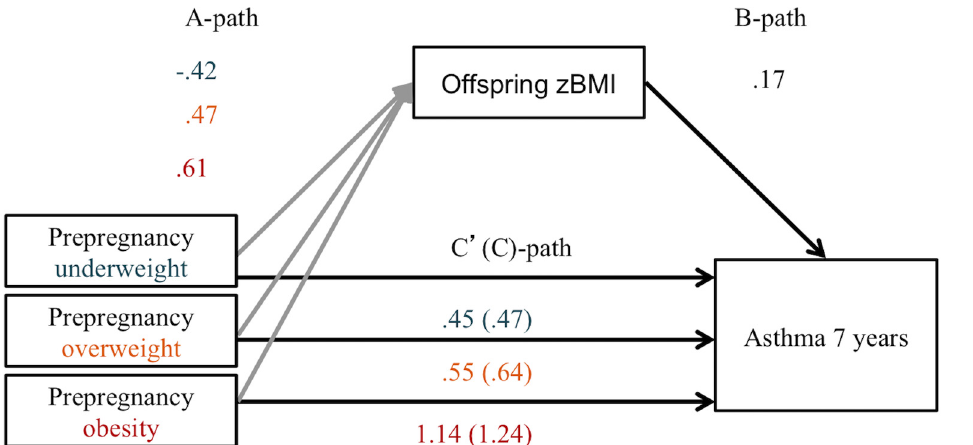
Fig 3. Indirect effect of pre-pregnancy BMI on ever asthma at age 7 – 8 years through offspring BMI z-score at age 5 years (n = 1787). Adjusted for: maternal age, parental asthma, ethnicity, maternal education, A-path: a-coefficient describing the change in offspring ’ s zBMI per BMI category in comparison to normal maternal BMI. B-path: b-coefficient describing change in offspring asthma risk per 1 point change in offspring zBMI when maternal BMI is constant. C ’ (C)-path: direct (total) effect.